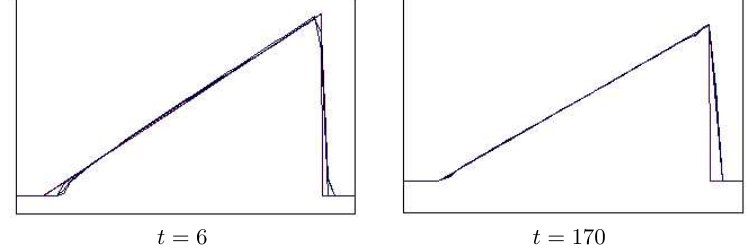
Figure 12. Numerical solution for the Babenko scheme for 1 initial data ( (cid:13) = 0 : 1; 0 : 5; 0 : 9 ).